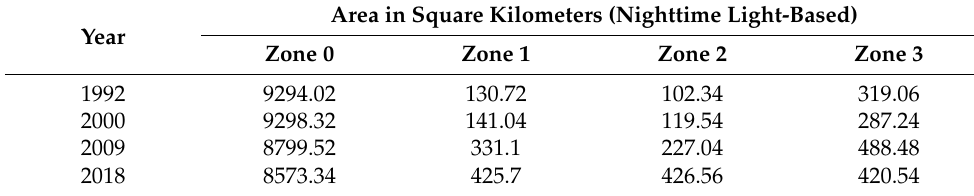
Table 3. Area Calculation for the Representative Years When Nighttime Light is Considered.